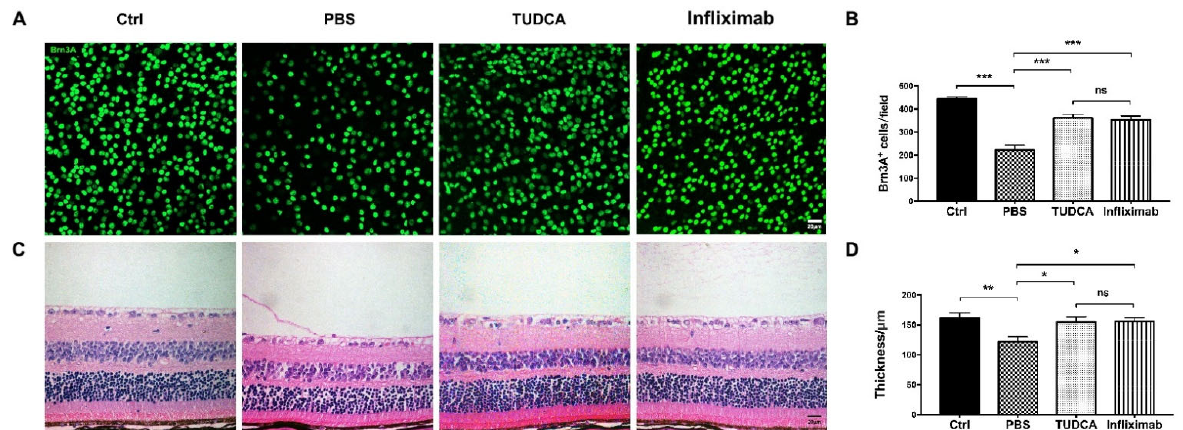
Figure 3. TUDCA preserves the structure of the retina after OAB. ( A ) Representative Brn3A (retinal ganglion cell marker) immunoreactivity in retinal whole mounts from control and alkali burn eyes treated with PBS, TUDCA, or infliximab on day 7 post-injury. ( B ) Quantitative analysis of Brn3A + cells. ( C ) The pictures of the control and injury retinas treated with PBS, TUDCA, or infliximab were taken 7 days after OAB. ( D ) Quantitative analysis of retinal whole thickness. Data are expressed as mean ± SEM ( n = 8 regions/mouse of six mice, * p < 0.05, ** p < 0.01, *** p < 0.001; ns, no significance). Scale bar: 20 μ m. Ctrl, control; OAB, ocular alkali burn; TUDCA, tauroursodeoxycholic acid.